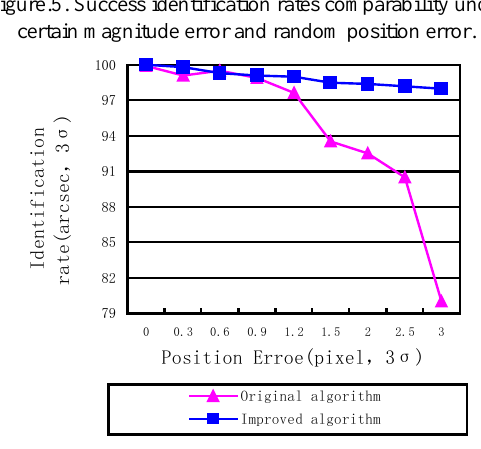
Figure.6. Success identification rates comparability under certain position error and random magnitude